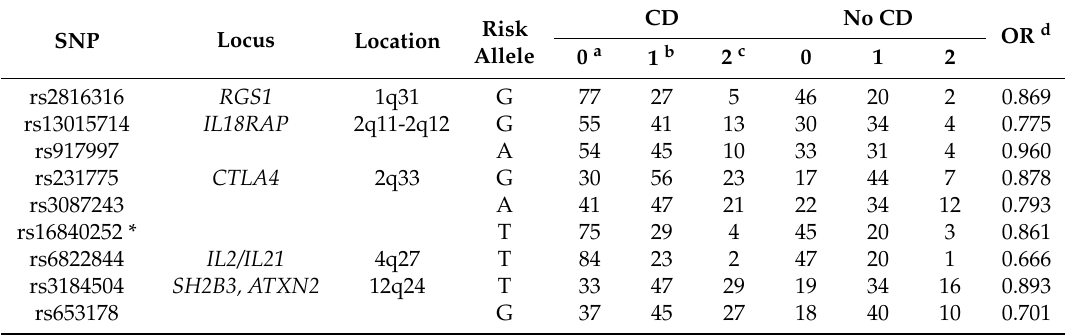
Table 1. Single nucleotide polymorphisms (SNPs) used for the DNA diagnostic method and the distributions of risk alleles in the study groups CD (Celiac disease) and No CD.